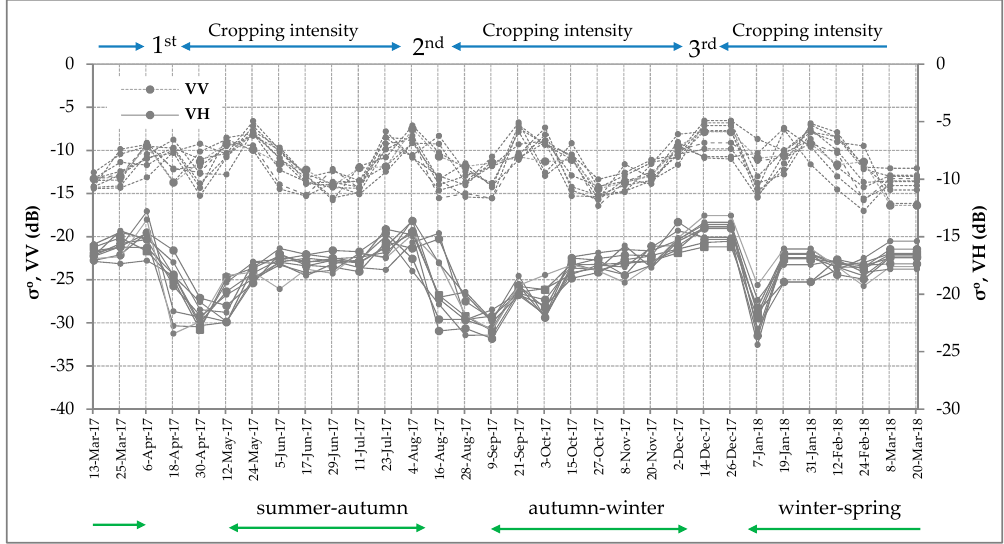
Figure 8. Graph representing the multitemporal Sentinel-1A backscattering in the triple rice cropping area. The first vertical axis is σ ◦ VV and the second vertical axis is σ ◦